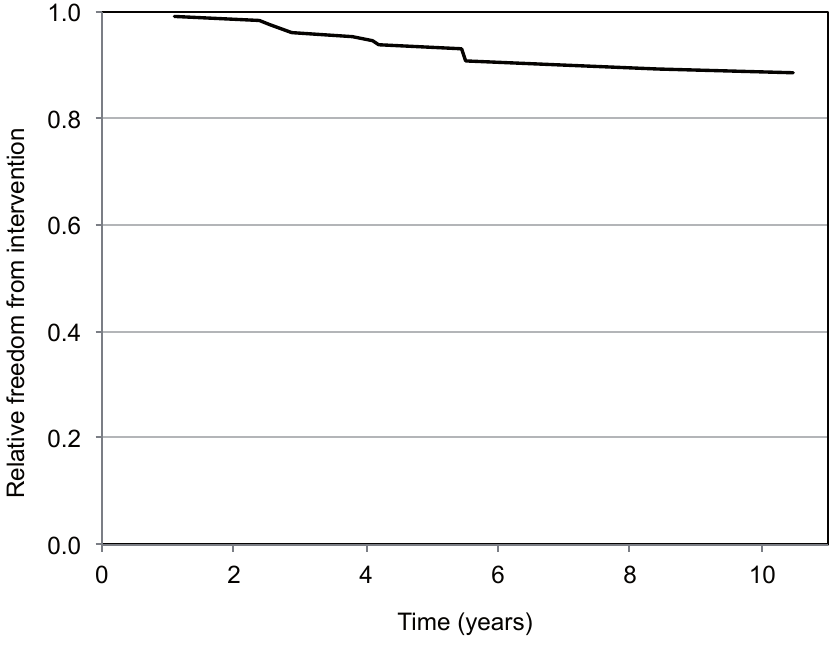
figure 4 - kaplan-Meier curve describing the annual likelihood of a renal mass requiring